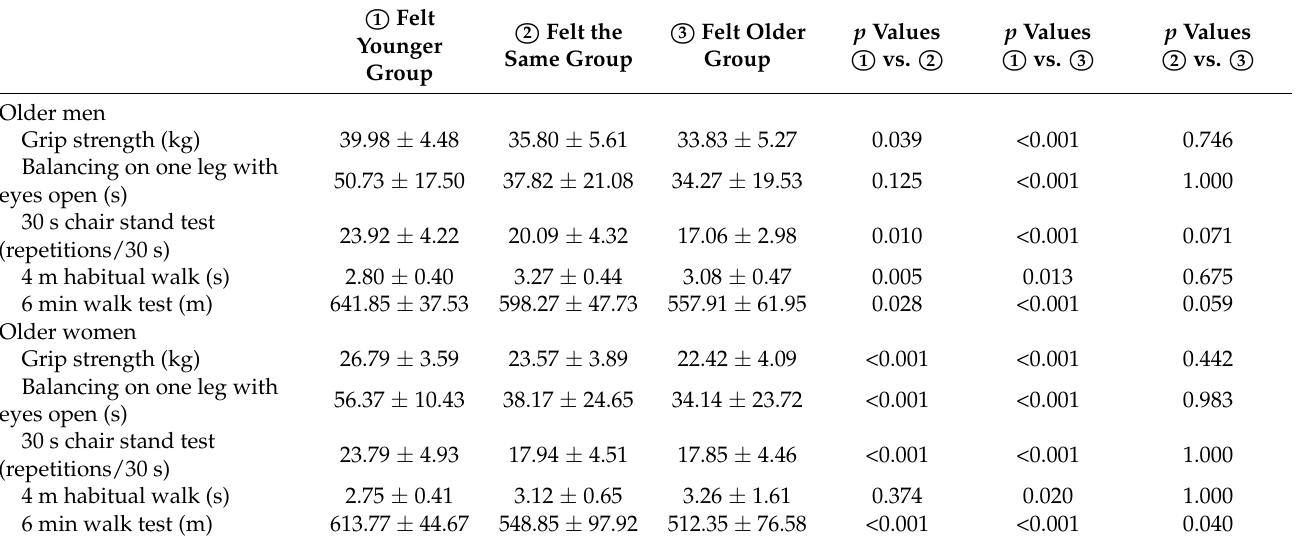
Table 2. The measured values of the physical fitness items across three different felt age groups in older men and